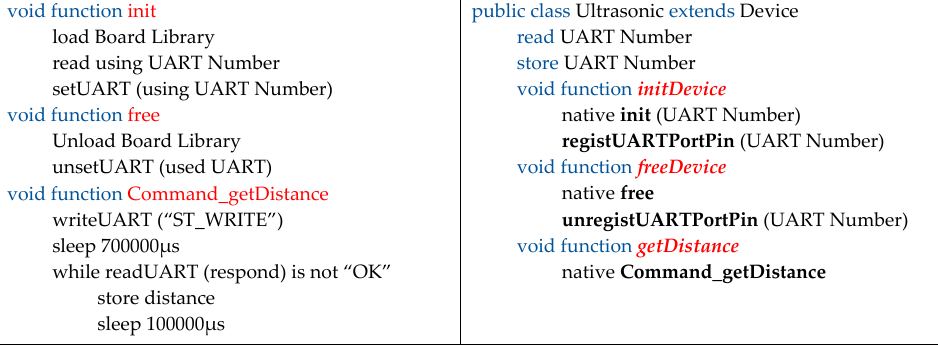
Figure 11. Device controller C ( left ) and device driver Java ( right ) development for ultrasonic sensors.